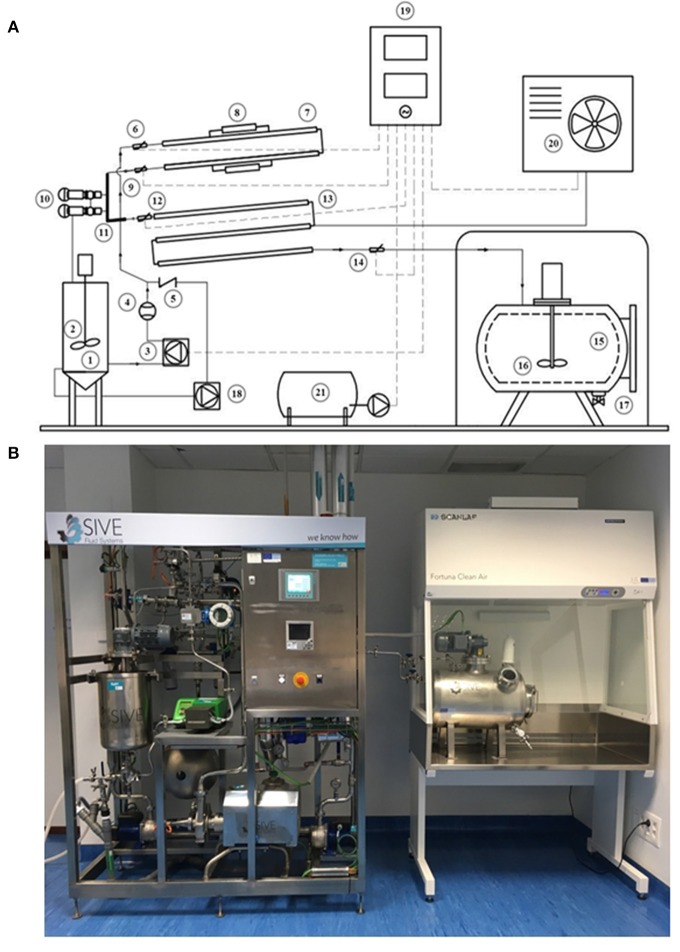
HTST system developed to process DHM. (A) Schematic diagram of the HTST equipment showing its basic components and milk flow. 1: Feed vessel for raw milk; 2: Stirring system; 3: Peristaltic pump; 4: Flowmeter; 5: Backflow valve; 6: Temperature probe; 7: Heating section; 8: Thermal resistances; 9: Temperature probe; 10: Safety valves; 11: Holding tube; 12: Temperature probe; 13: Cooling section; 14: Temperature probe; 15: Closed isothermal tank for pasteurized milk; 16: Stirring system; 17: Filling system; 18: Secondary pump; 19: Control unit; 20: Cold generation equipment; 21: Air compressor. (B) Equipment for the HTST treatment of donor milk at the Regional HMB “Aladina-MGU”.